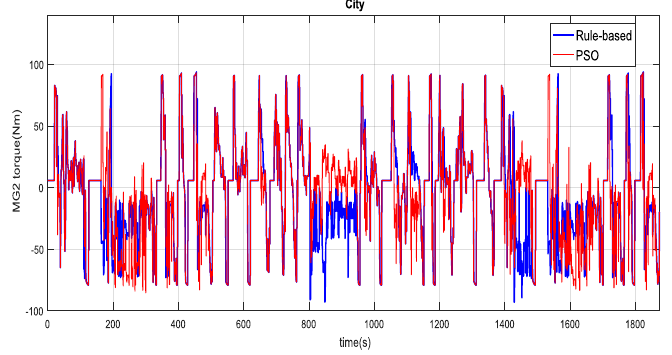
Figure 22. M/G2 torque in the urban driving cycle. Figure 22. M / G2 torque in the urban driving